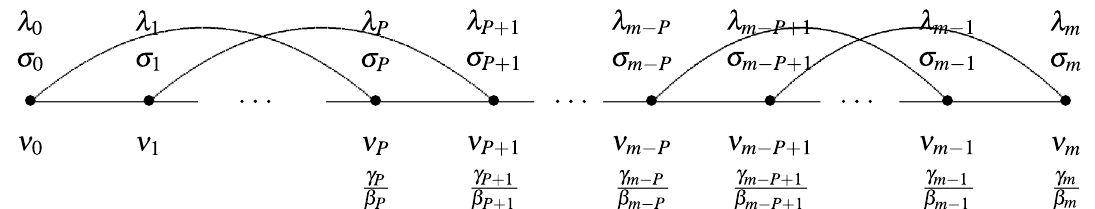
Figure 3. The time nodes and the subsets of fixed length of P + 1 days for identifying β( t ) and γ( t )